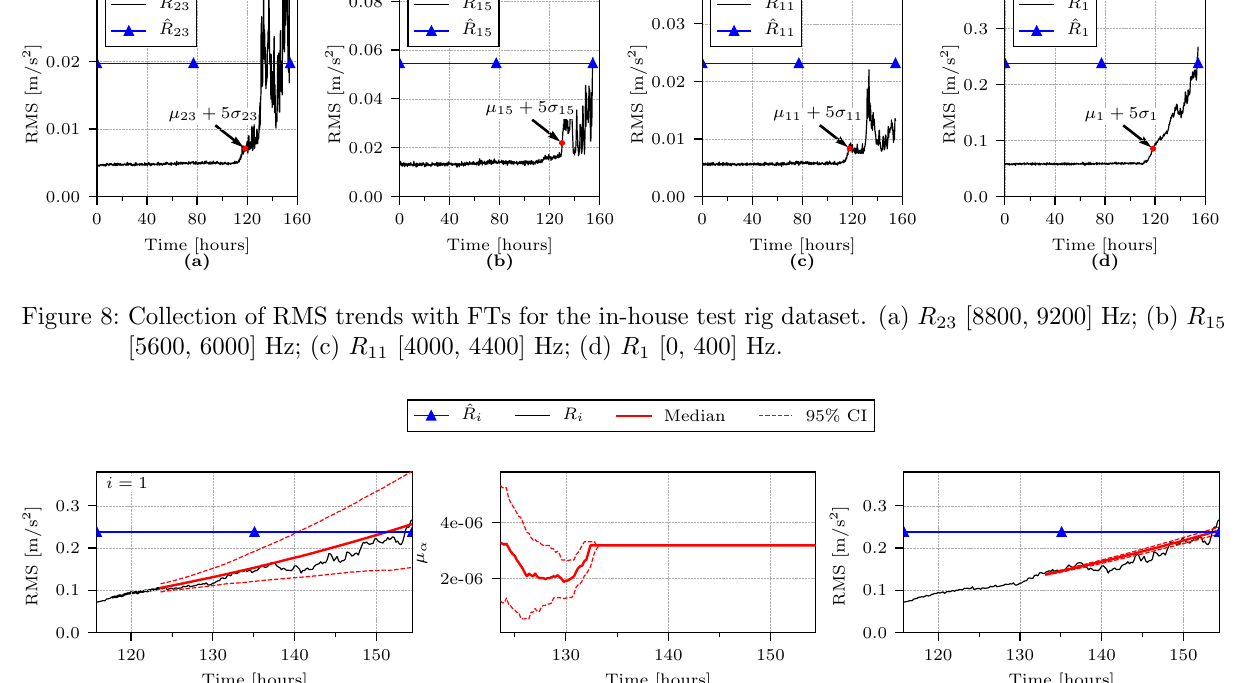
Figure 9: R and initial median and 95% CI output of the corresponding PF. (a) R 1 optimization input, blue line for FT, and red lines for median and 95% CI of PF; (b) α over time for the initiated PF; (c) predicted PF trend when µ